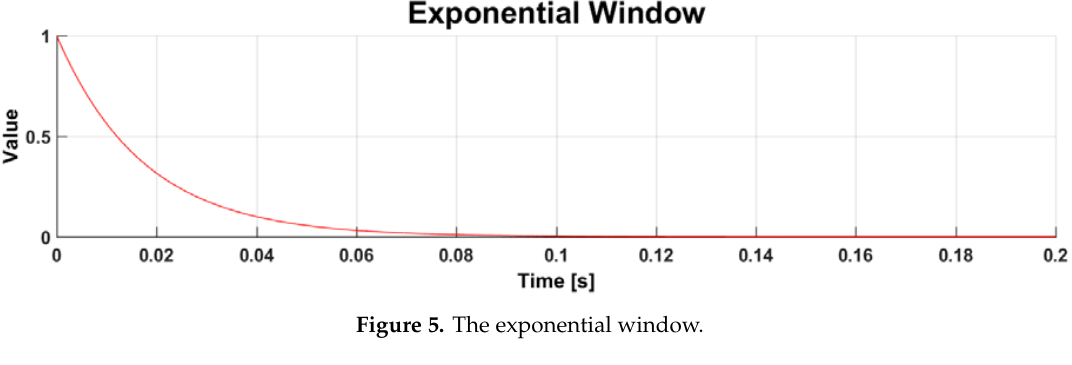
Figure 5. The exponential window.